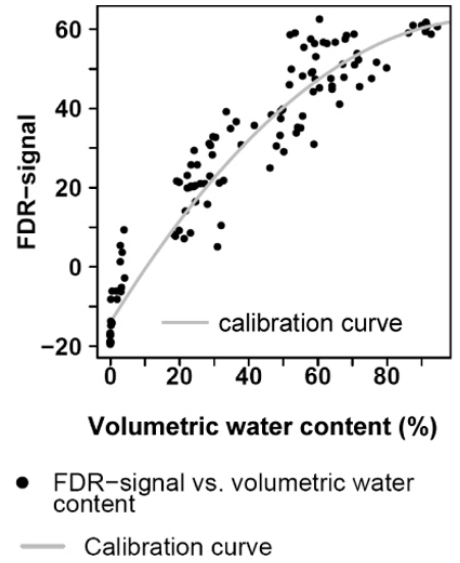
Fig. 1. Output of Function Domain Reflectory (FDR) probes plot- ted against measured volumetric water content in calibration exper-